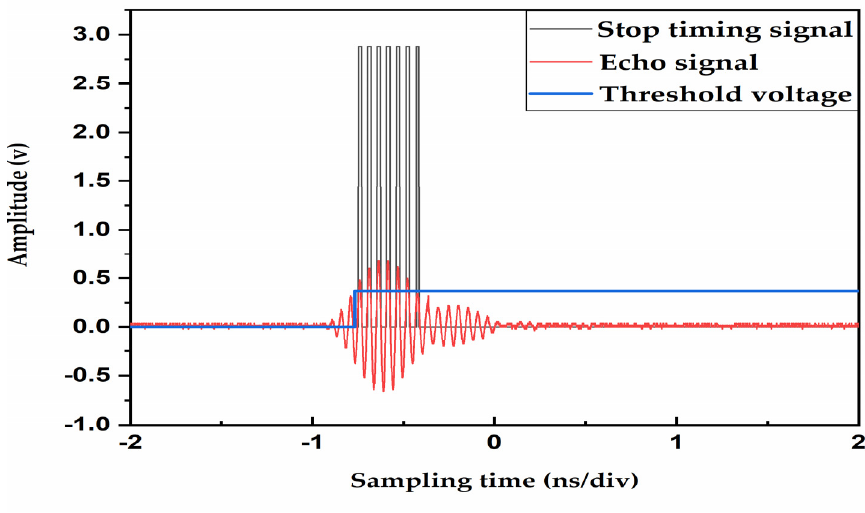
Figure 6. Threshold and zero-crossing comparison circuit generate the stop-timing signal.